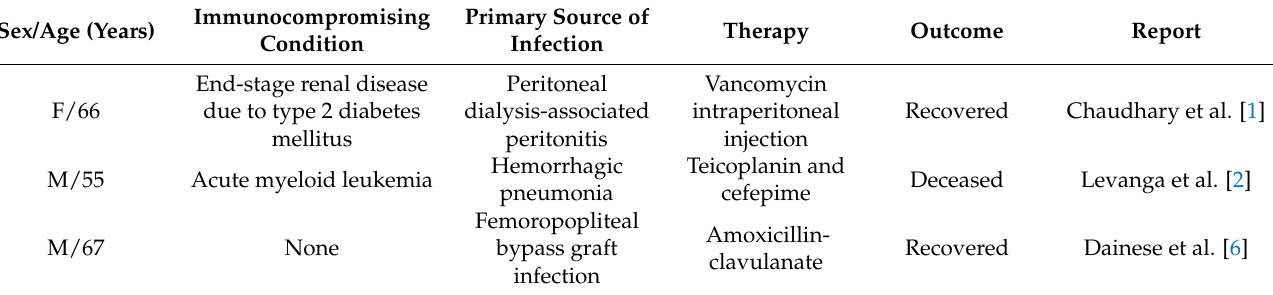
Table 1. Reported cases of Kytococcus sedentarius